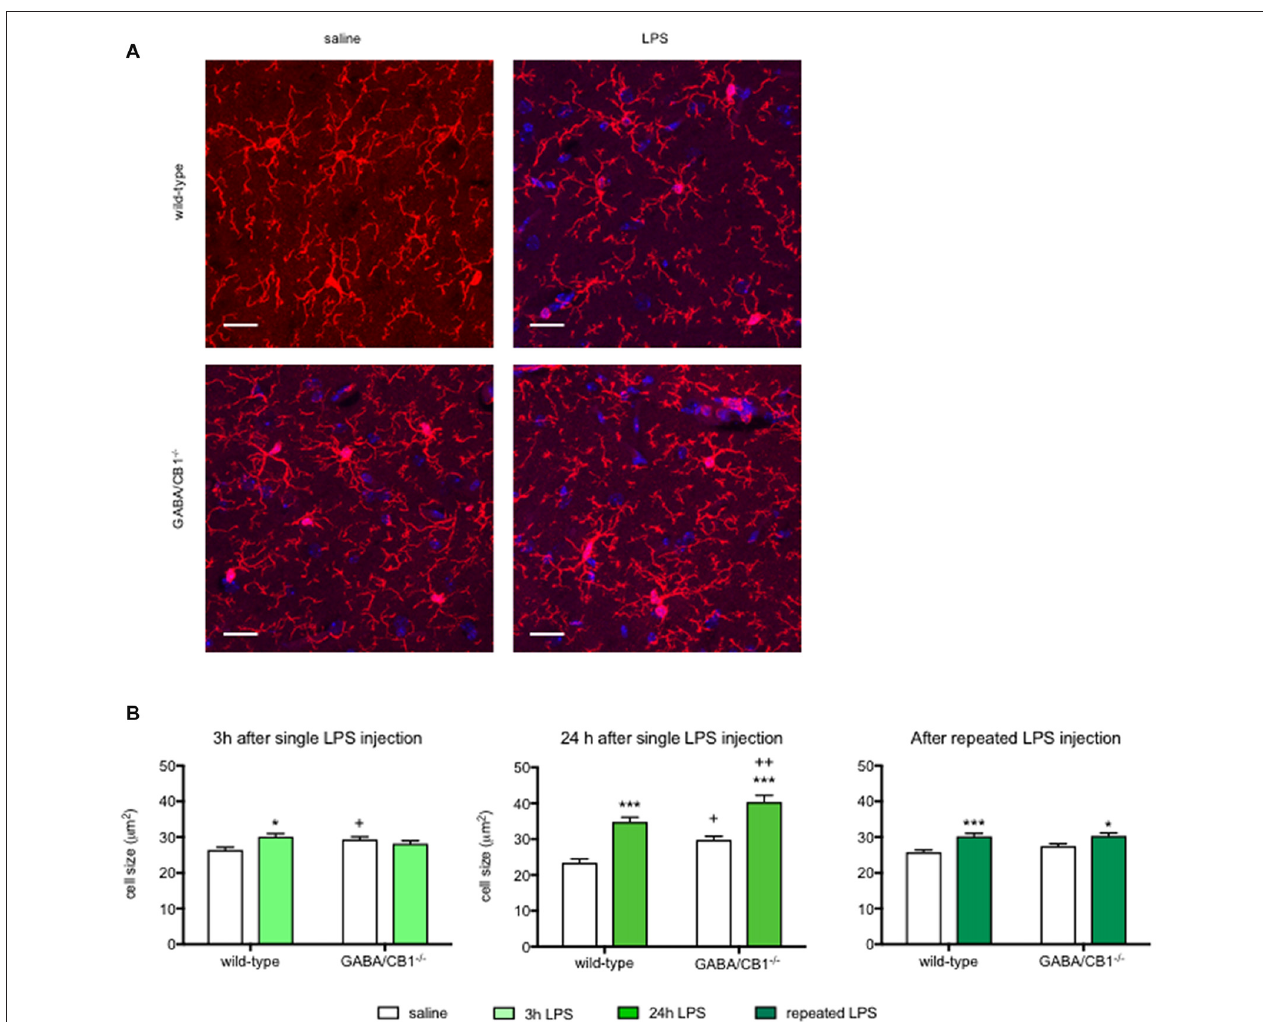
FIGURE 3 | (A) Representative microphotograph of Iba1 immunostaining (red) and DAPI fluorescence showing cell nuclei (blue) in the hippocampus of WT and GABA/CB1 − / − mice 24 h after four times daily intraperitoneal LPS injections. Scale bar represents 20 µ m. (B) Size of Iba1+ microglia cells in the hippocampus of WT and GABA/CB1 − / − mice 3 h after an intraperitoneal LPS-treatment ( n = 143–150); 24 h after an intraperitoneal LPS-treatment ( n = 136–145) and 24 h after four times daily intraperitoneal LPS injections ( n = 138–150). ∗ p < 0.05; ∗∗∗ p < 0.001 difference between saline and LPS-treated mice using Bonferroni’s t -test. + p < 0.05; ++ p < 0.01 difference between WT and GABA/CB1 − / − mice with the same treatment using Bonferroni’s t